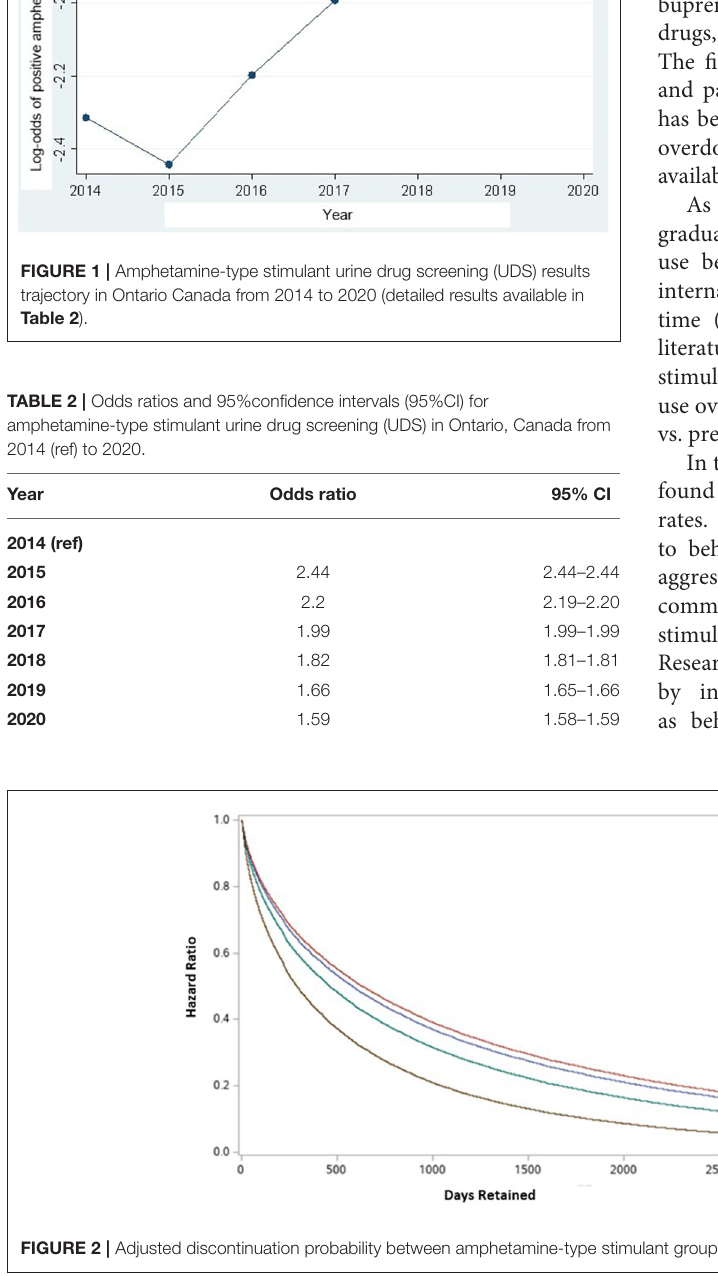
Frontiers in Psychiatry |